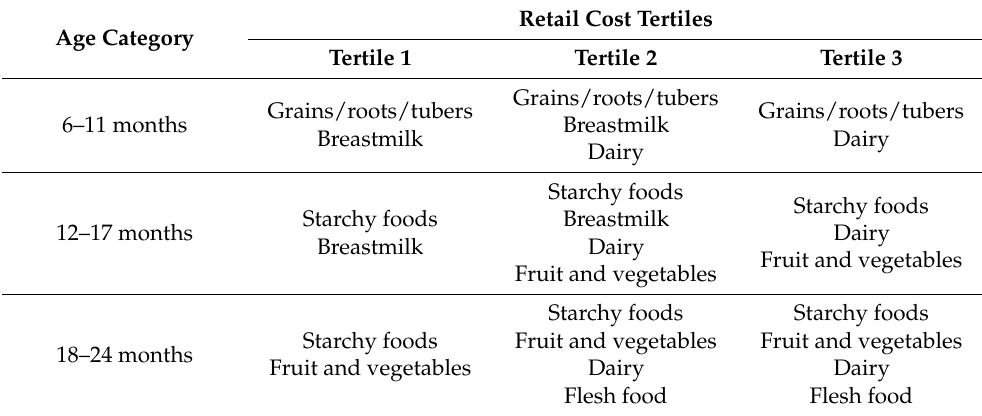
Table 4. Food groups predominantly included (>50%) according to retail cost